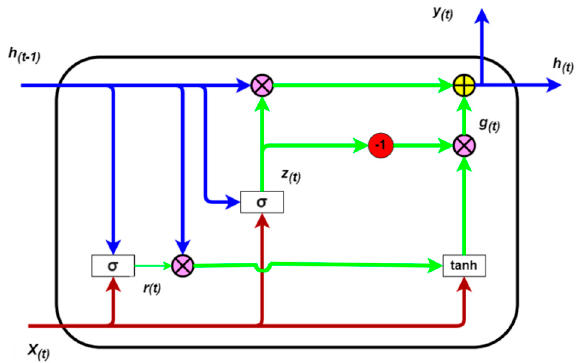
Figure 3. Gated recurrent unit cell; h ( t − 1 ) is hidden state from previous step, X ( t ) is current input, h ( t ) is new hidden state, y ( t ) is output, r ( t ) is reset gate, z ( t ) is update gate, g ( t ) is candidate hidden state, 𝜎 is sigmoid function, tanh is hyperbolic tangent function [18].